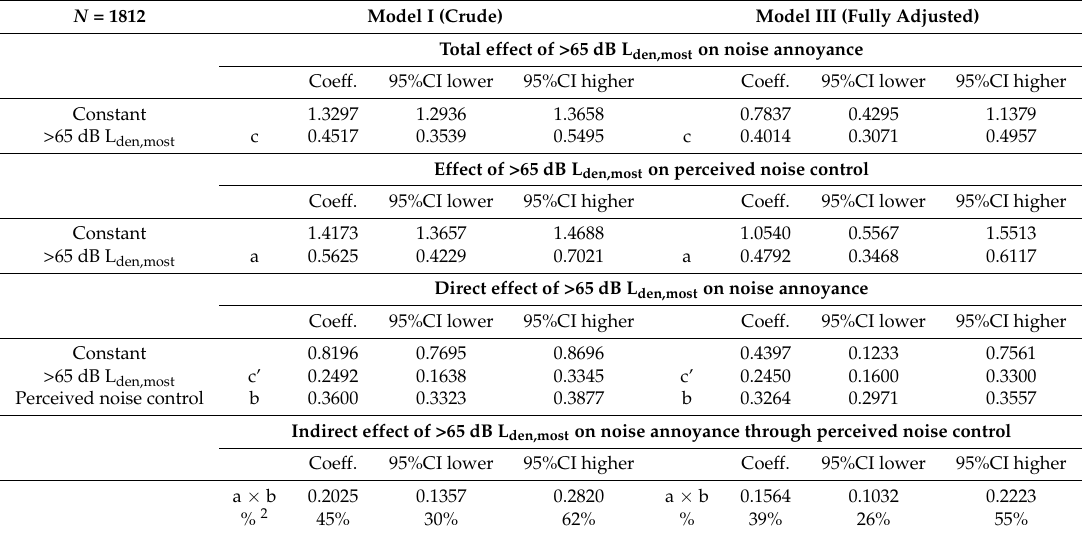
Table 3. Association of exposure to road traffic noise (>65 dB L den,most ) with perceived noise control and noise annoyance 1 .